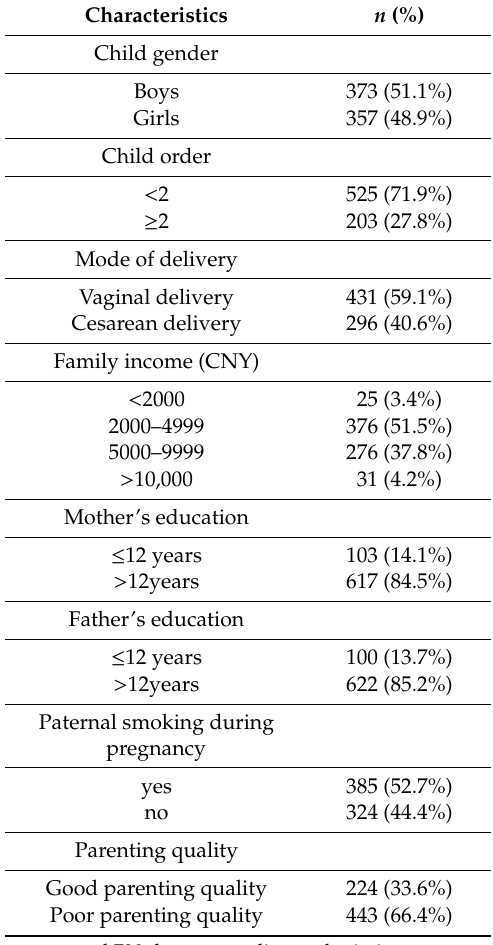
Table 1. Participant demographics among the included 730 children.